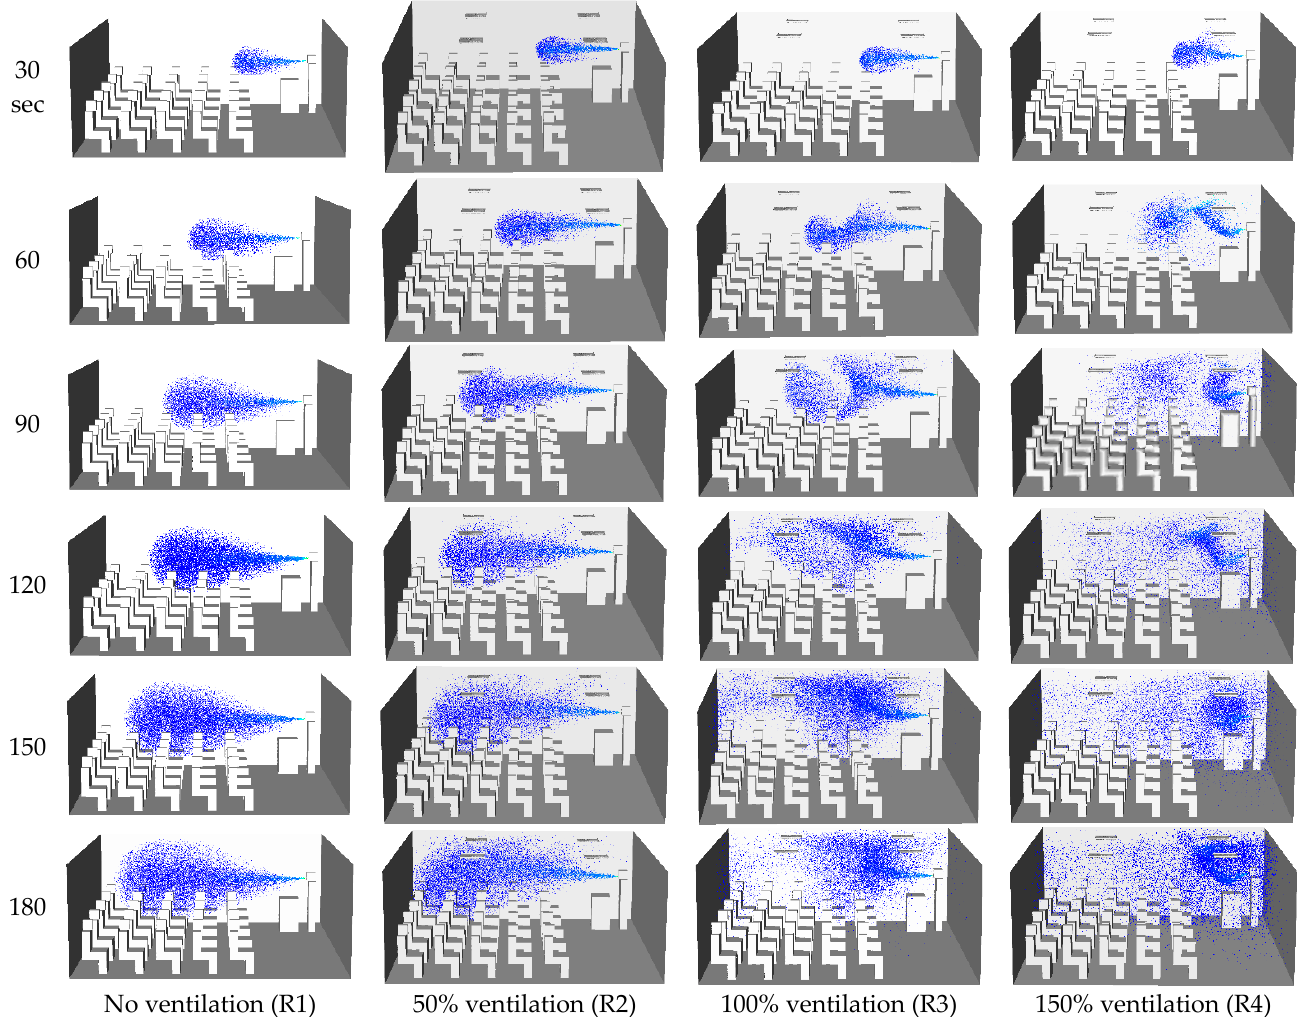
Figure 8. Time tracking of aerosol droplets with the time course and different ventilation rates (scenarios R1–R4).